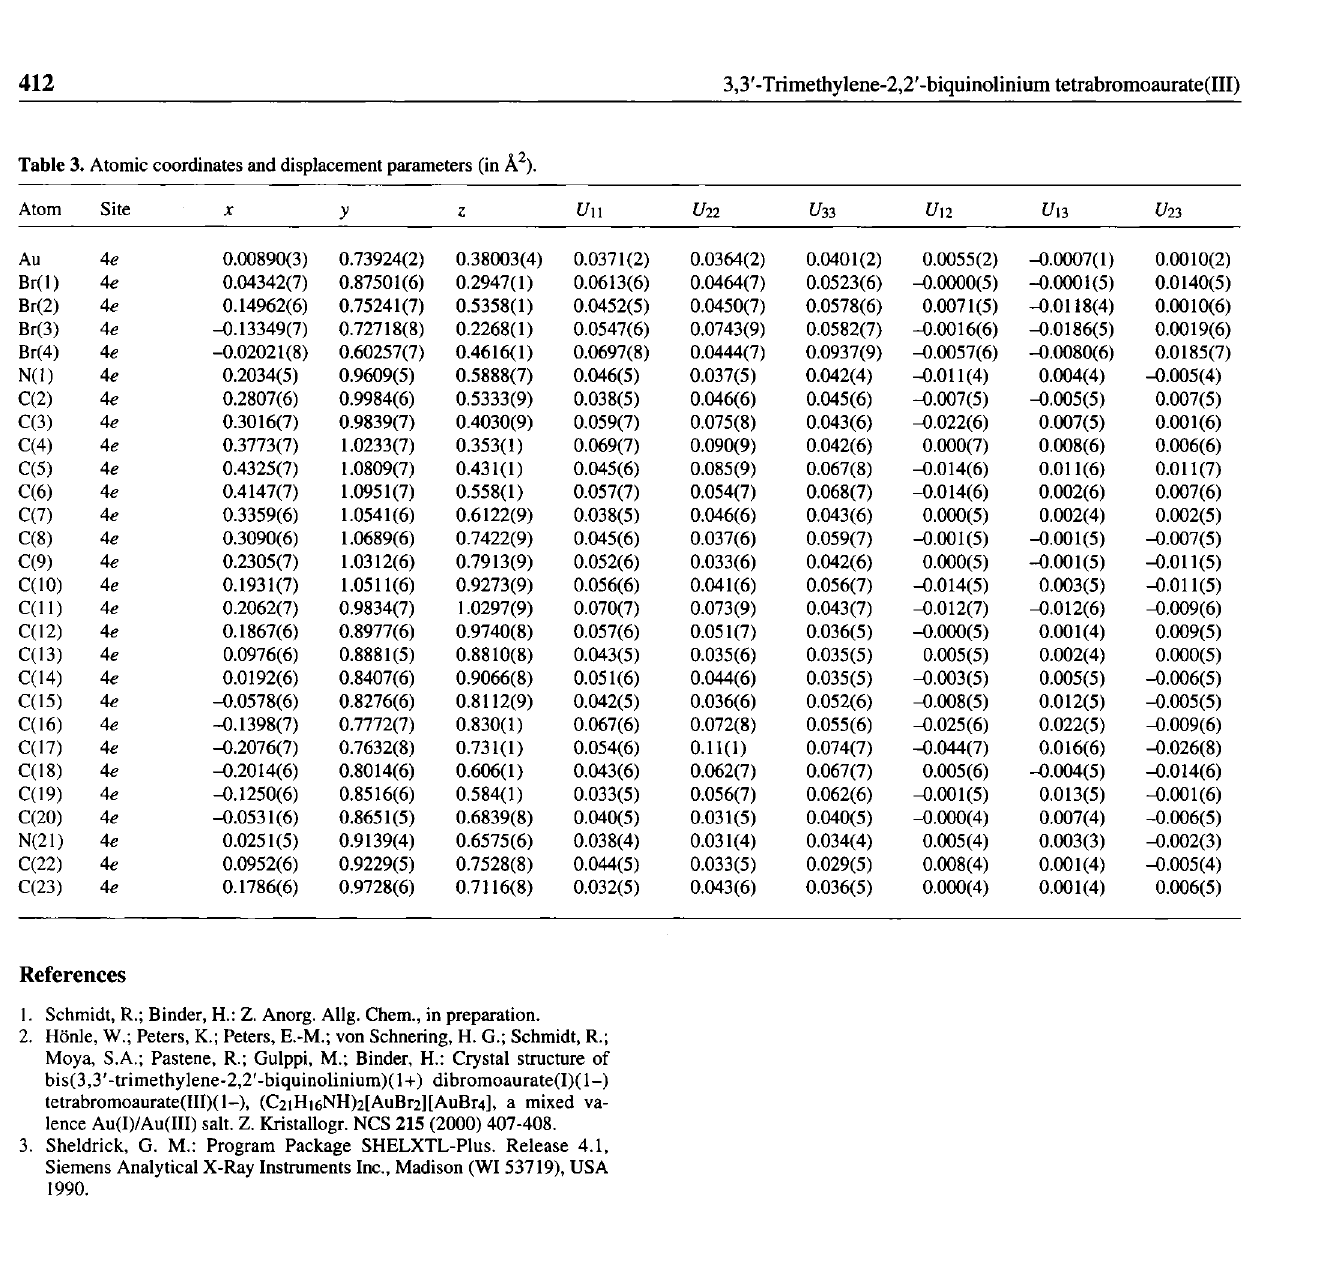
Table 3. Atomic coordinates and displacement parameters (in Ä 2